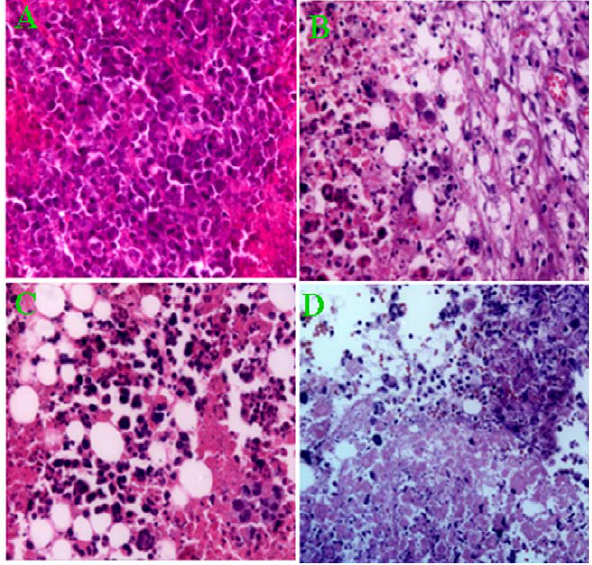
Figure 4. Histological assay of tumors of H22 tumor-bearing mice that received different treatments. (hematoxylin and eosin stain, 400 6 magnifications). A large number of necrotic cells as well as vacuoles were observed in tumors in mice of the DOX-PGMNPs-M group (D), whereas only a few necrotic tumor cells could be seen in tumors in mice of the DOX (B) or DOX-PGMNPs groups (C). Mostly viable tumor cells were observed in the tumors of the mouse control group